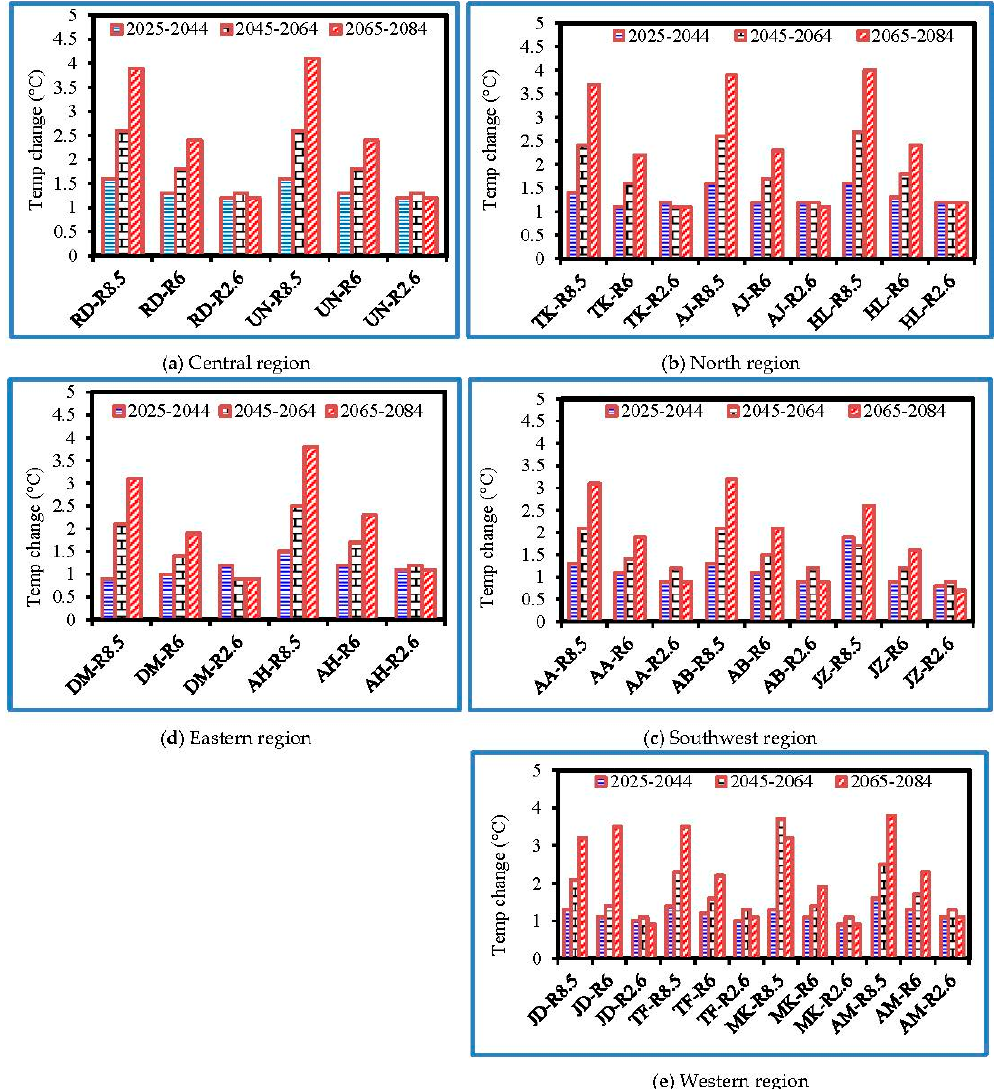
Figure 6. Prediction of temperature change with respect to the reference period (1986–2005). ( a ) Central region; ( b ) North region; ( c ) Southwest region; ( d ) Eastern region; ( e ) Western region; RD: Riyadh; UN: Unaizah; TK: Tabouk; AJ: Al-Jouf; HL: Hail; AA: Abha; AB: Al-Baha; JZ: Jazan; DM: Dammam; AH: Al-Hofuf; JD: Jeddah; TF: Taif; MK: Makkah; AM: Al-Madinah; R8.5: RCP8.5 (High emission scenario); R6: RCP6 (High-medium emission scenario); R2.6: RCP2.6 (Low emission scenario).